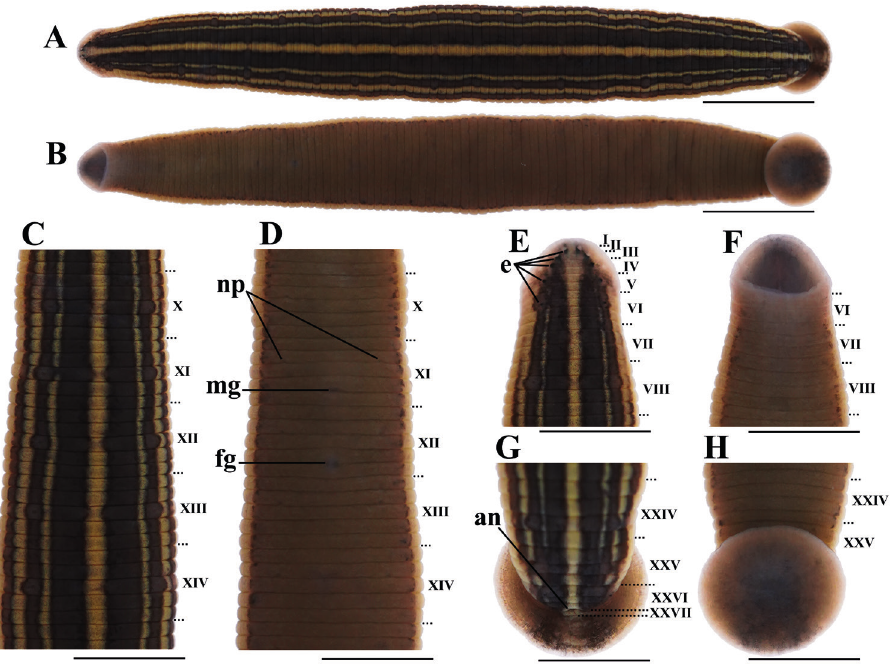
Figure 2. External morphology of H. tianjinensis holotype A dorsal and B ventral view of whole body C dorsal and D ventral view of somites X–XIV E dorsal and F ventral view of somites I–VIII G dorsal and H ventral view of somites XXIV–XXVII and caudal sucker. Abbreviations: an, anus; e, eye; fg, female gomopore; mg, male gomopore; np, nephridiopores. Scale bars: 5 mm ( A, B ), 2.5 mm ( C–H